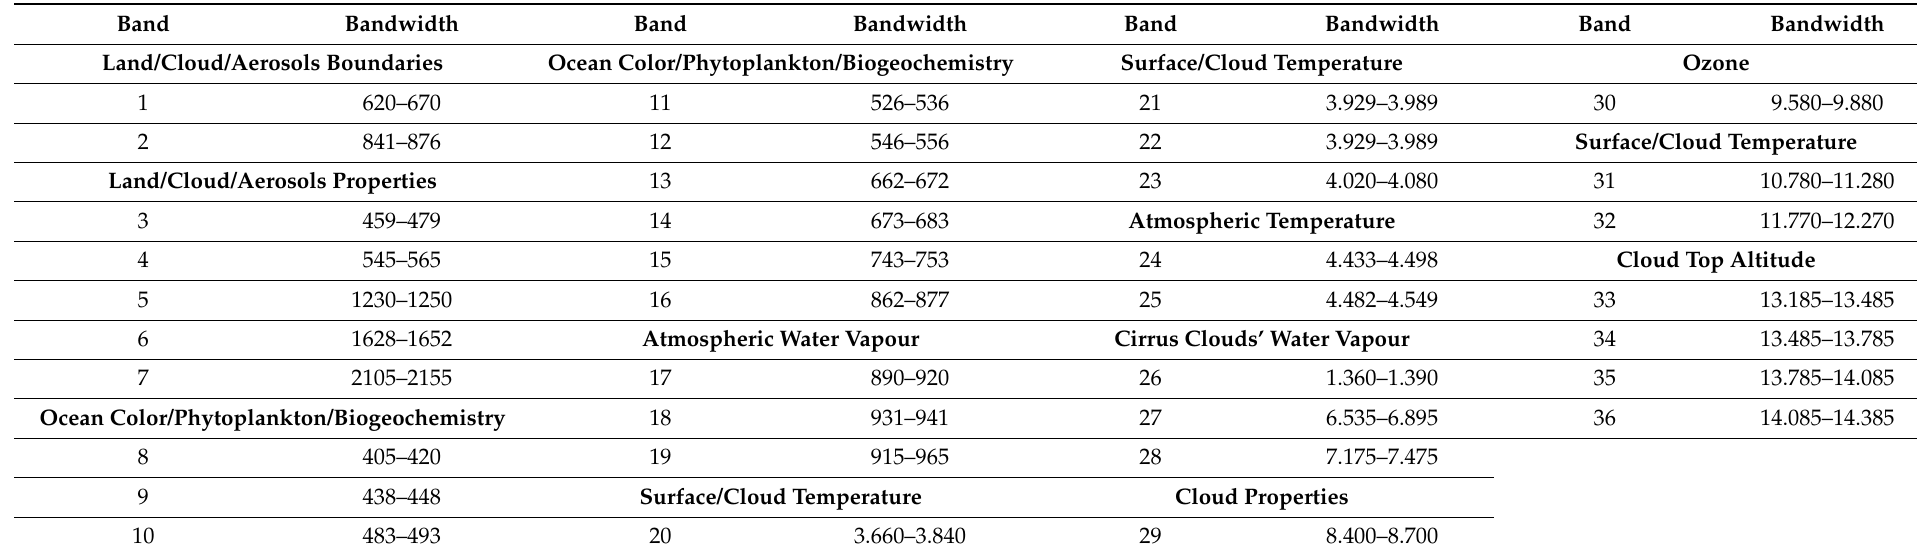
Table 1. The characteristics and functions of the 36 bands of MODIS data satellite